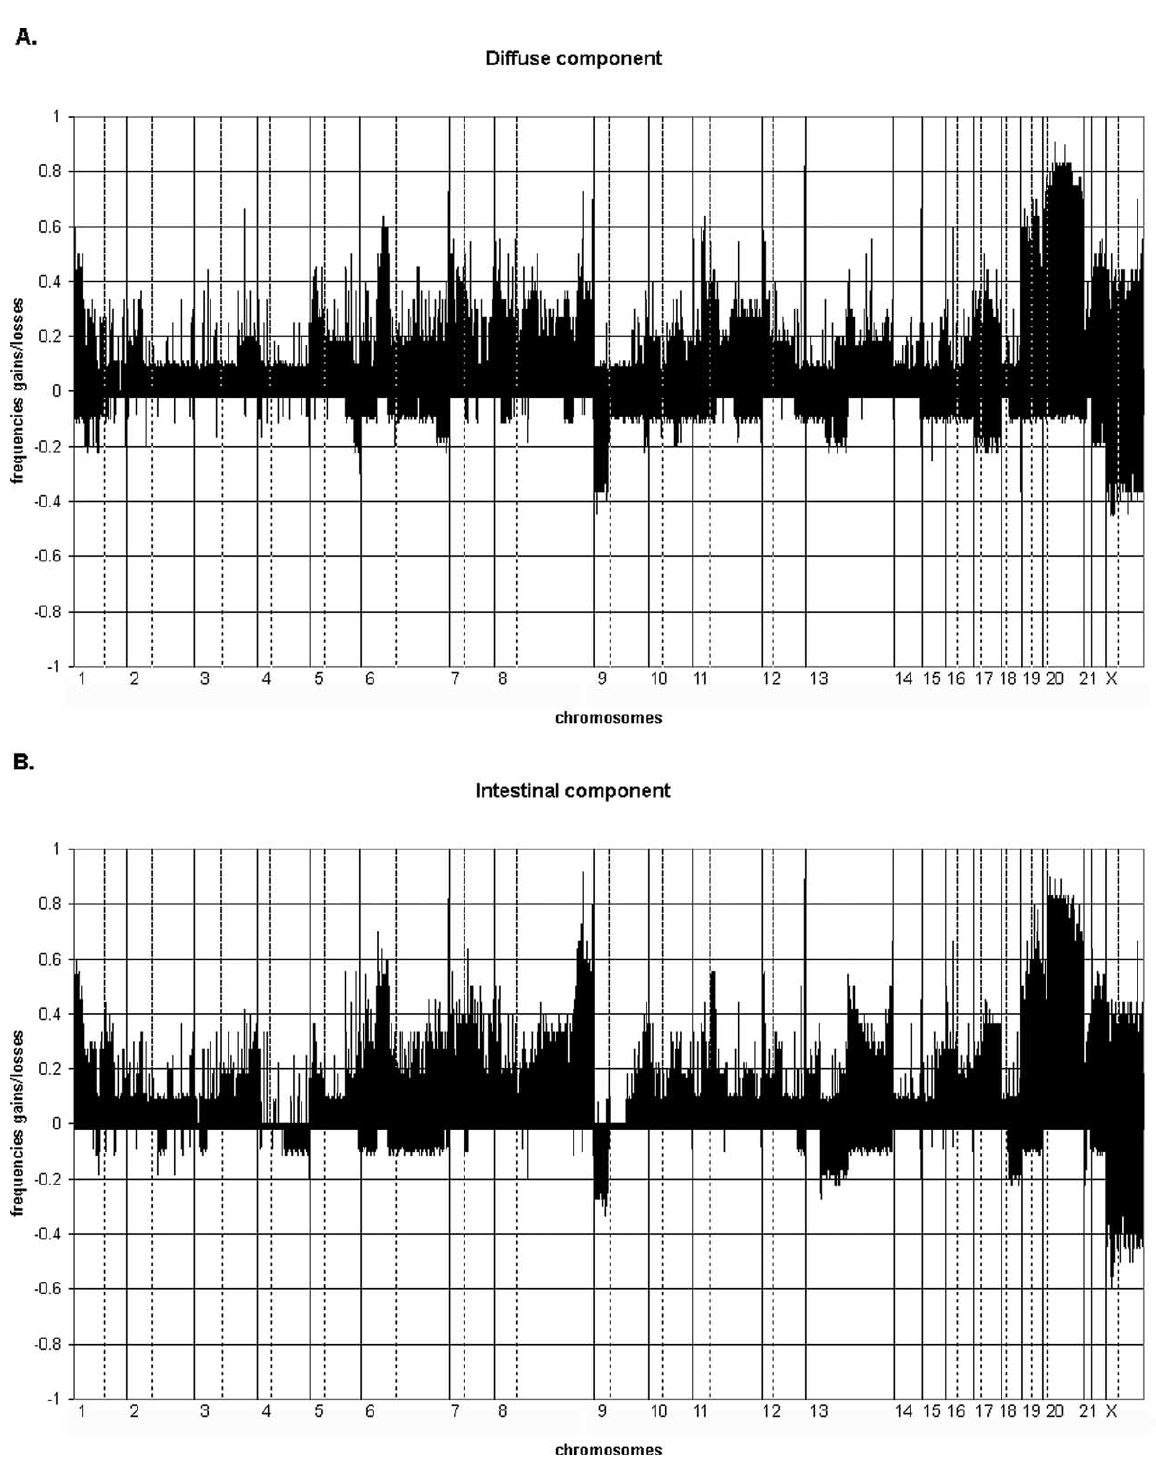
Fig. 1. Frequencies of gains and losses throughout the genome in all analysed tumours. (A) Diffuse-type component; (B) Intestinal-type compo- nent. Clones are sorted by position per chromosome (1-X). Vertical lines – transition between chromosomes; Dashed-vertical lines – centromere